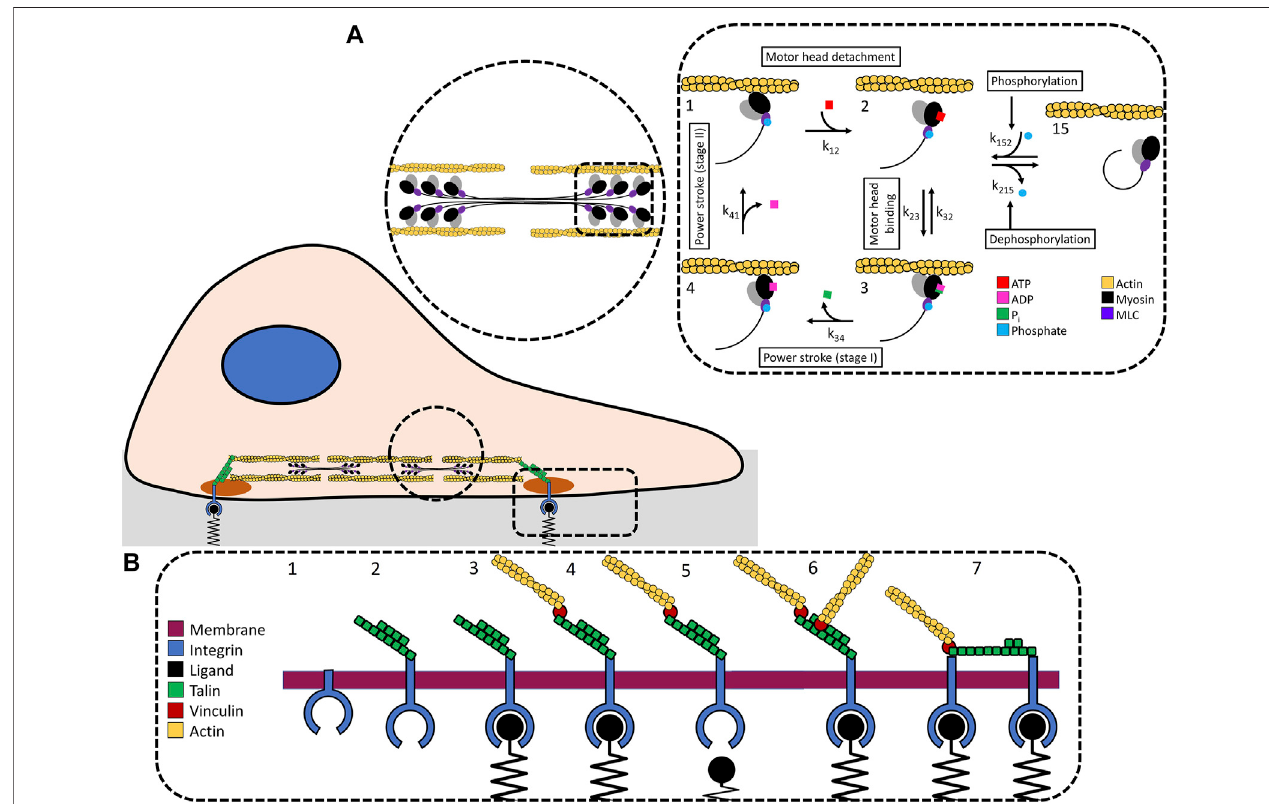
FIGURE 1 | (A) We use a stochastic model of the actin-myosin crossbridge cycle. The force generated by myosin motors interacting and stepping along actin fi laments. Force is transmitted to the integrins attached to the adhesion plaque. (B) Integrin dynamics: 1) Deactivated integrin. 2) Integrin activates when talin binds to integrins intracellular domain. 3) This activates the extracellular domain and allows it to bind to substrate ligands. 4) Once attached to the substrate, vinculin and actin- myosin fi laments attach to talin. The force is transmitted to integrin. 5) If the force is too great, the integrin-substrate bond will break. If the applied force does not break the integrin-substrate bond it is possible for talin to 6) recruit additional actin-myosin fi laments via vinculin binding, or 7) branch to a neighboring integrin.